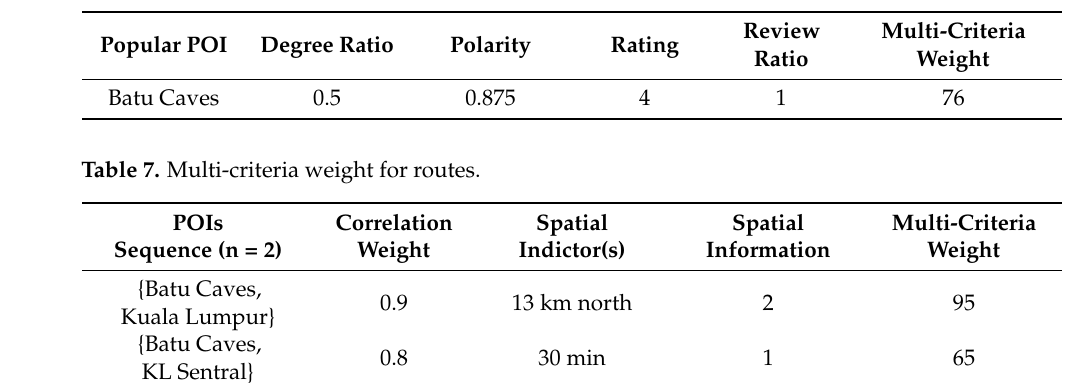
Table 6. Multi-criteria weight for POI.